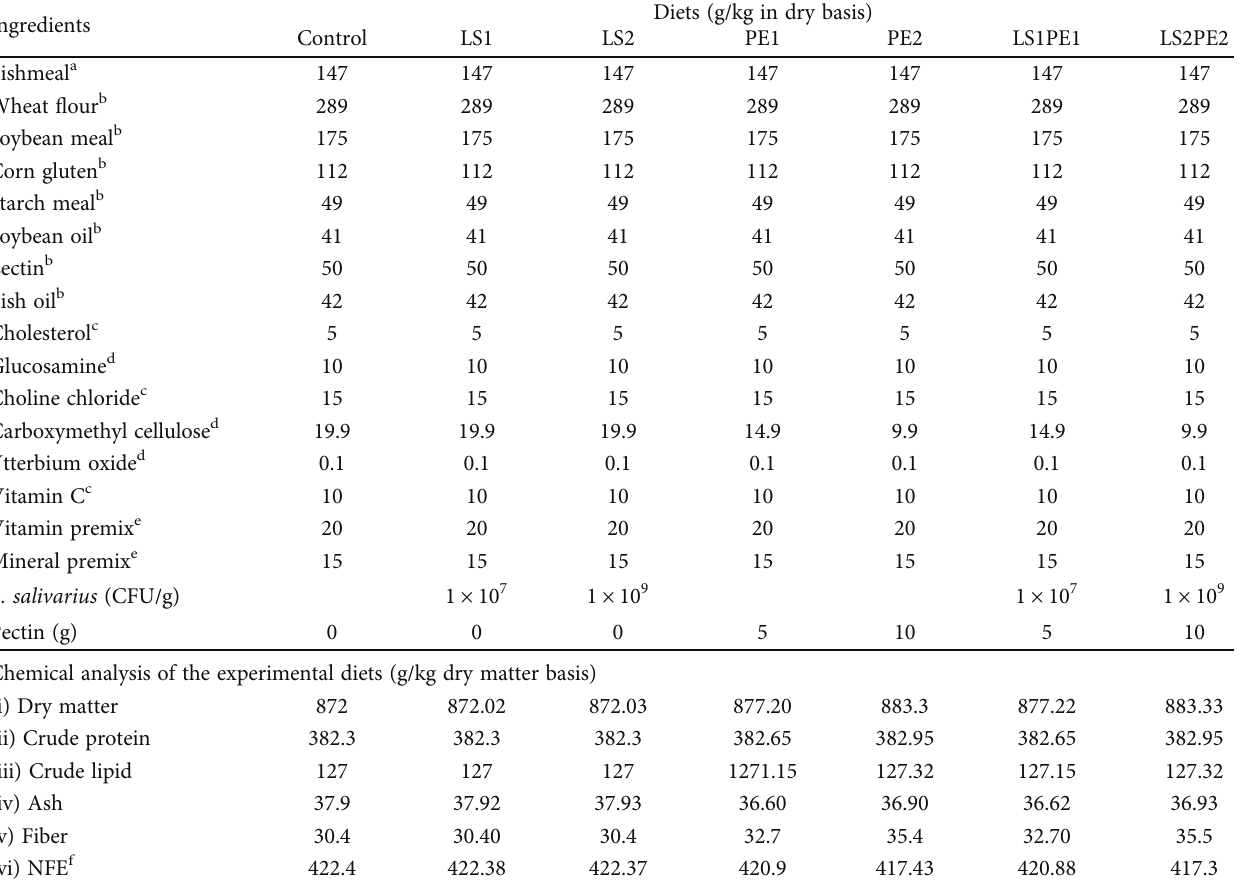
Table 1: Feedstu ff and proximate analysis of the experimental